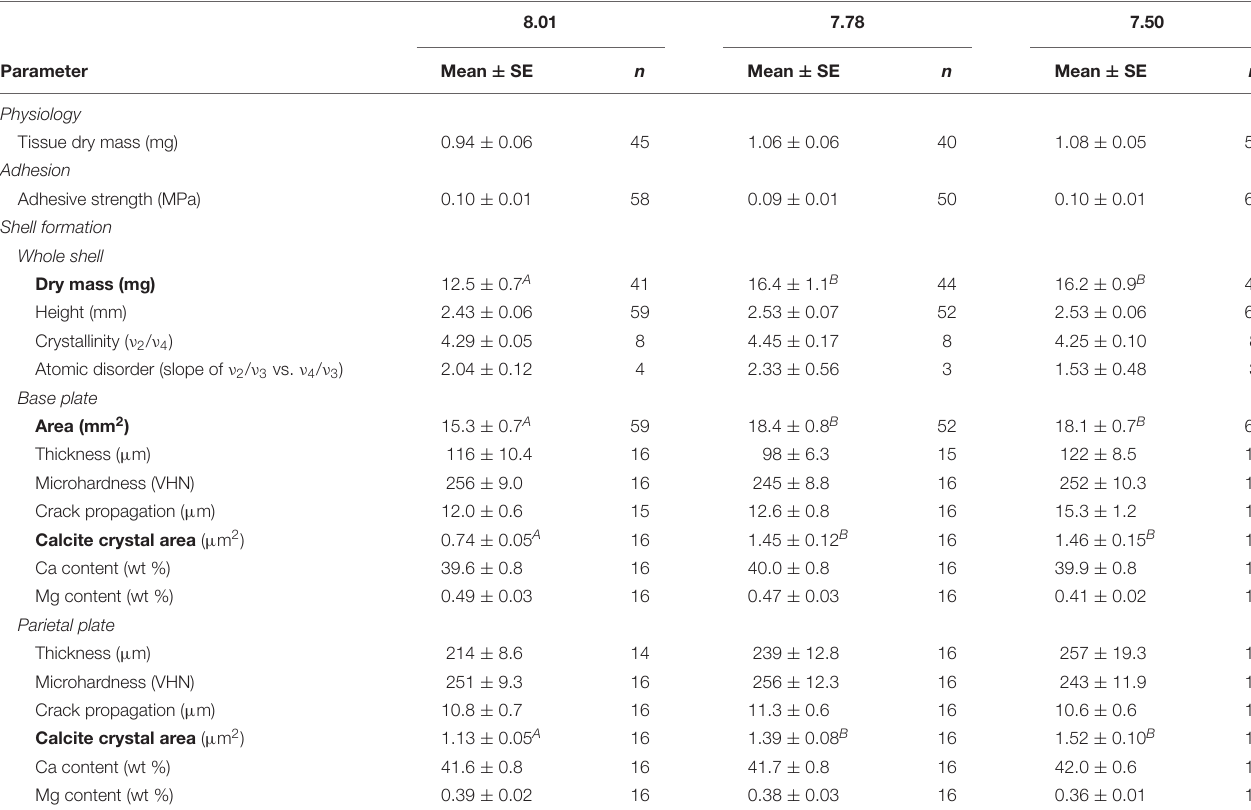
TABLE 3 | Summary statistics for physiology, adhesion, and shell formation metrics.